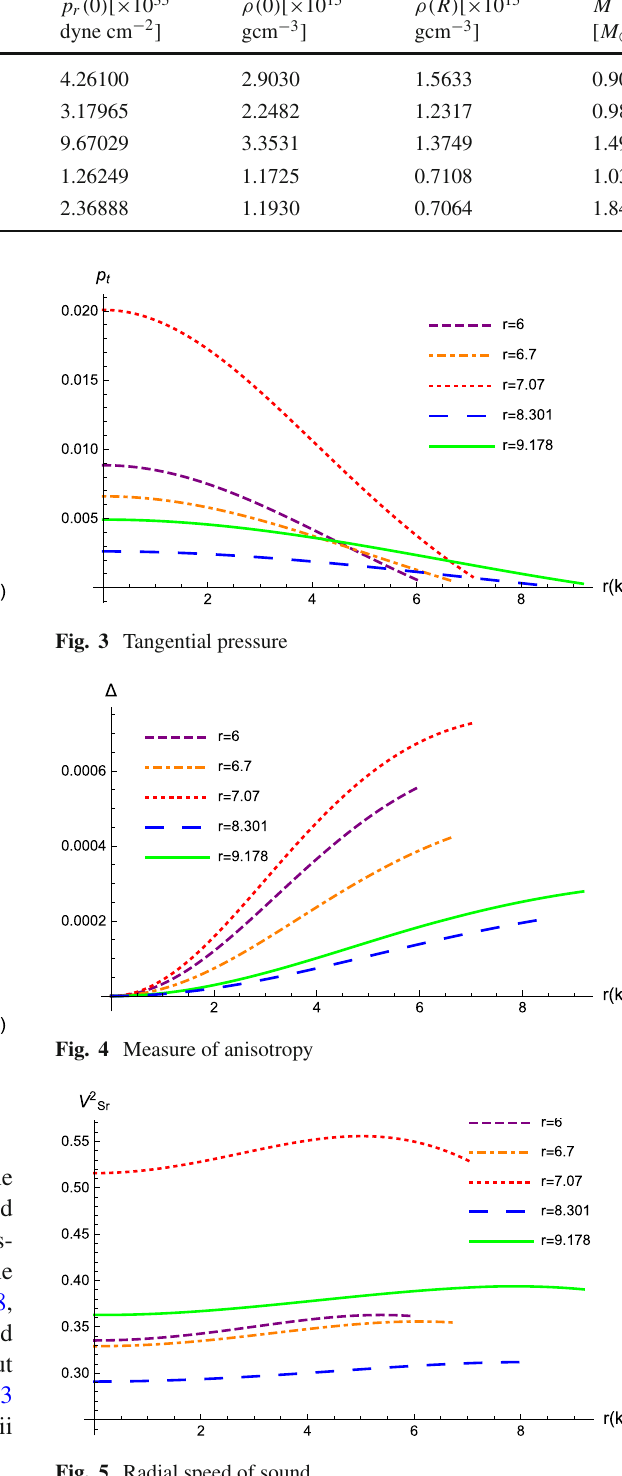
Fig. 5 Radial speed of